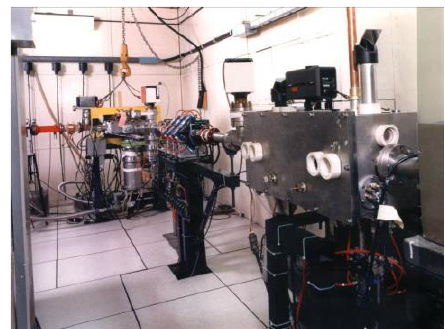
Fig. 1 . The ENEA Compact FEL